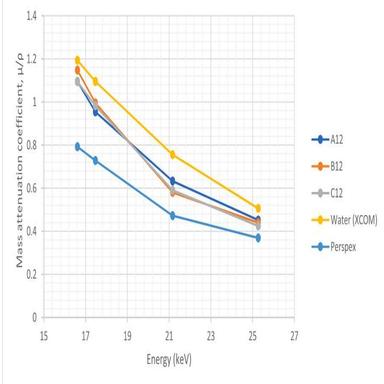
The mass attenuation coefficients of Rhizophora spp. particleboards with 12% adhesive in comparison with water (XCOM) and Perspex ® at energy range of 16.62–25.27 keV.